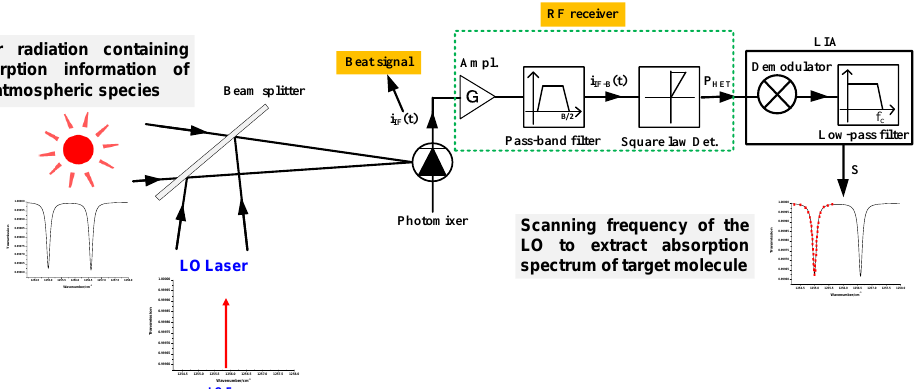
Figure 1. Basic principle of a typical laser heterodyne radiometer (LHR). RF: Radio frequency; IF: Intermediate frequency; LIA: Lock-in amplifier; LO: Local oscillator.